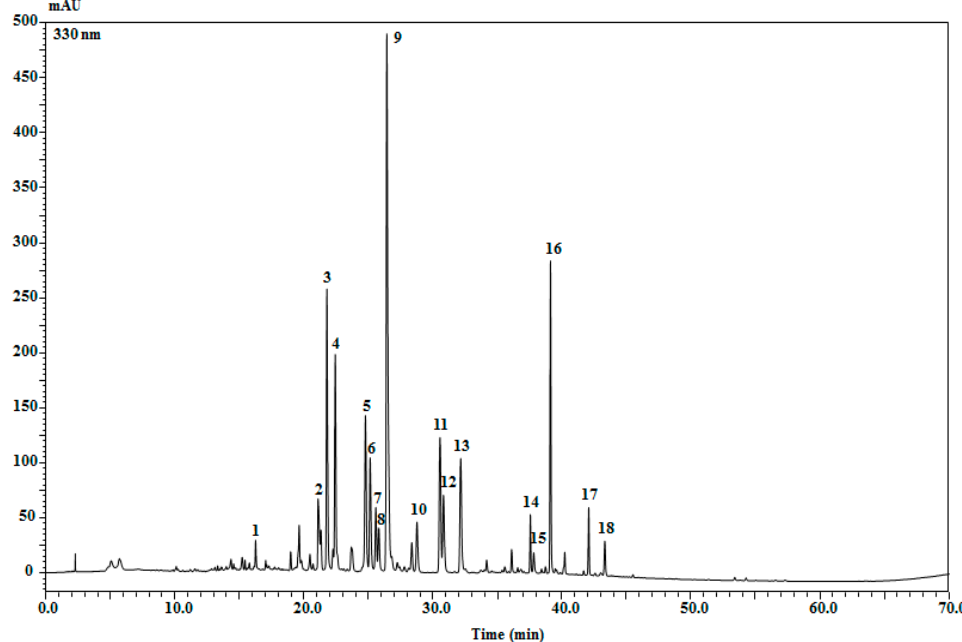
Figure 2. Chromatographic profile of phenolic compounds in the Rosa damascena extract (EtOH:H 2 O 7:3 v / v ) acquired at 330 nm.